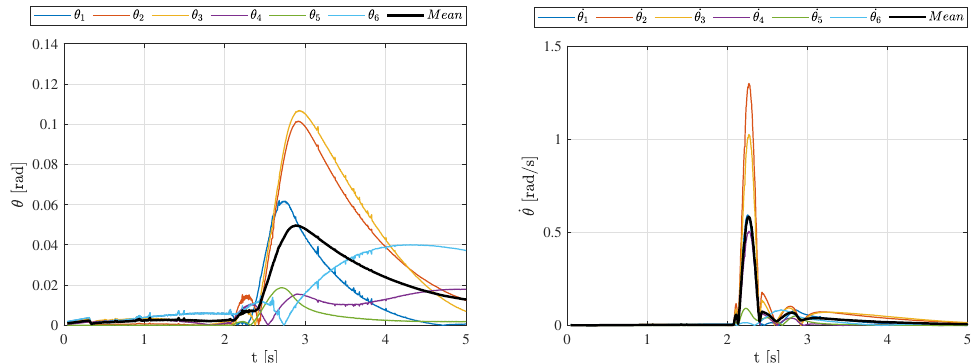
Figure 11. Test case 2, Mode I. The error between simulation and real system. Joint rotations ( left ) and joint speeds ( right ).